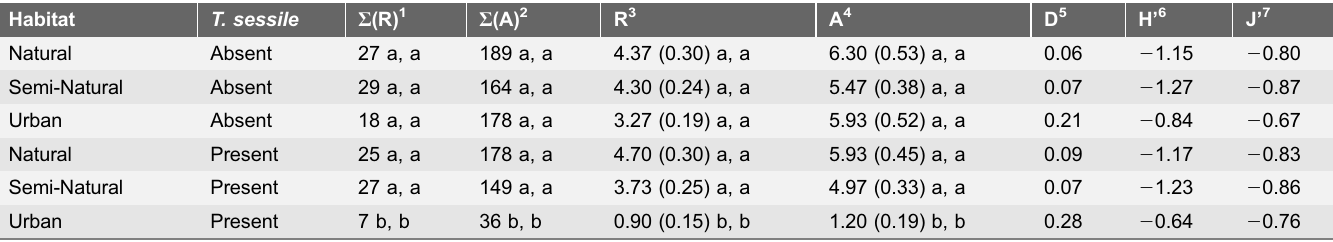
Table 2. Ant community composition in three habitats with and without Tapinoma sessile . Habitat